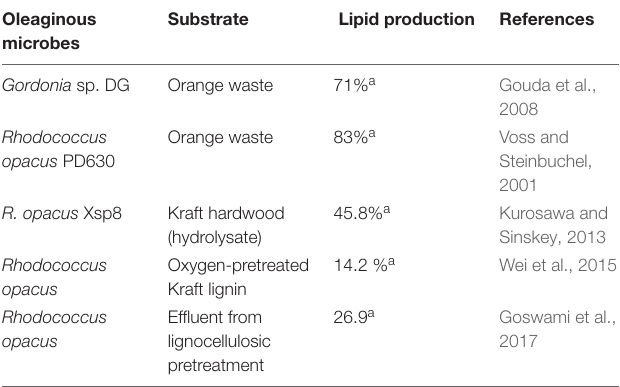
TABLE 4 | Lipid production by oleaginous bacteria using lignocellulose